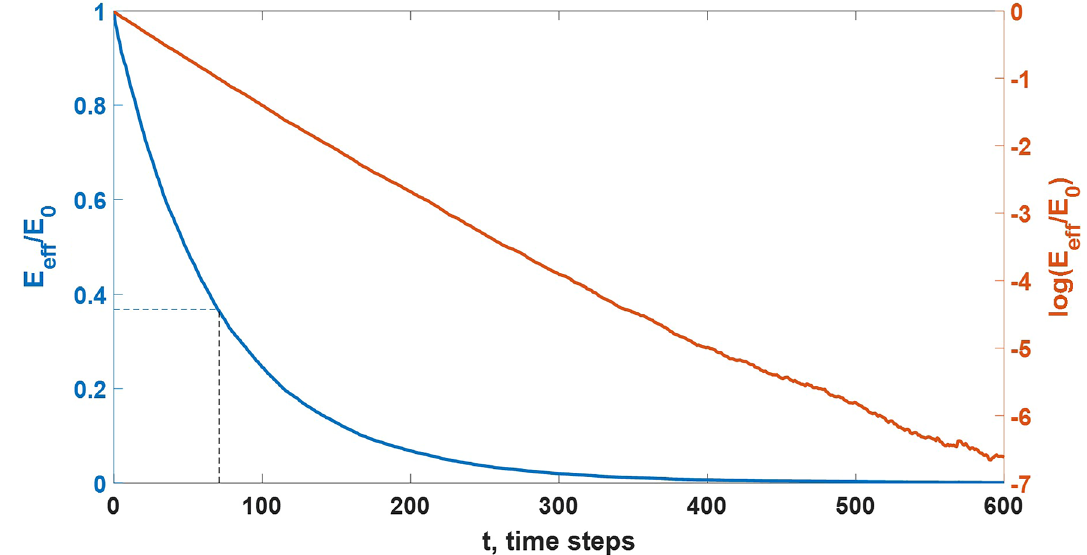
Figure 7. Dependence curves of normalized averaged electric field E eff calculated with the use of Eq. (7) (blue line) and its natural logarithm (orange line) vs time (expressed in time steps) for the field-independent case 10 % (a model time step τ m 0.1 % and u u τ l under p 0.1 s for the considered lifetime of a link τ l = = = = Dotted lines indicate the point ( τ , e − 1 ) which is used to find relay conductivity σ eff from Eq. (6).